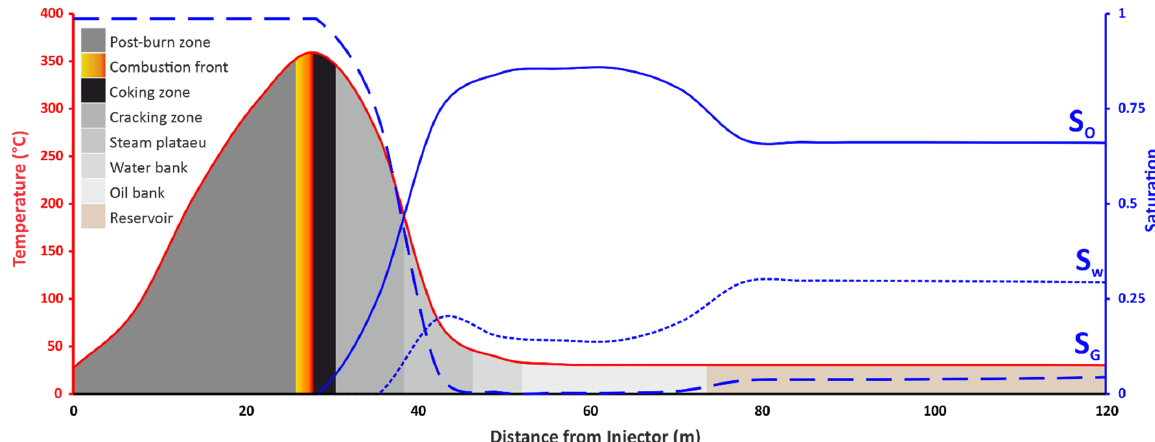
Figure 2. Schematic diagram showing a numerically modelled graph showing the water, oil and gas saturation along with the temperature profiles in the different zones created between the injector and producer during dry forward in-situ combustion, adapted from [2,9].